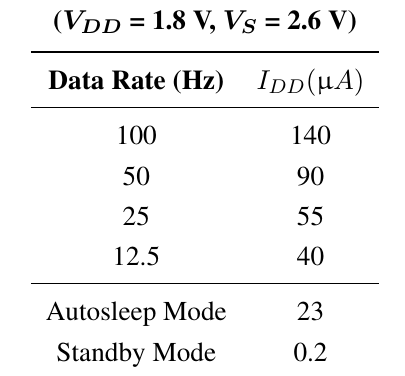
Table 1. The drained current vs. data rate in the accelerometer, ADXL346.